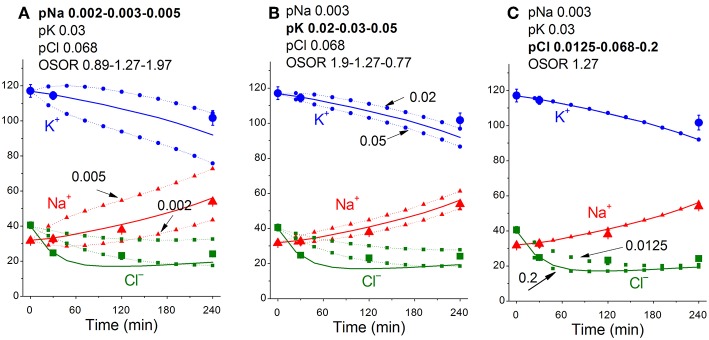
Dependence of the calculated K+, Na+, and Cl− redistribution dynamics during STS-induced apoptosis on K+, Na+, and Cl− channel permeabilities. Experimental data are shown by the large symbols. Solid lines—data calculated for the following parameters: na0 140, k0 5.8, cl0 116, B0 48.2, kv 1, na 32, k 117, cl 40, beta 0.029, gamma 1.5, pna 0.003, pk 0.03, pcl 0.068, inc 3E-6, ikc = inkcc = 0, kb 0.000068. Dotted lines with small symbols—data calculated for parameter values indicated above the graphs. OSOR values are given for a 4 h time point.